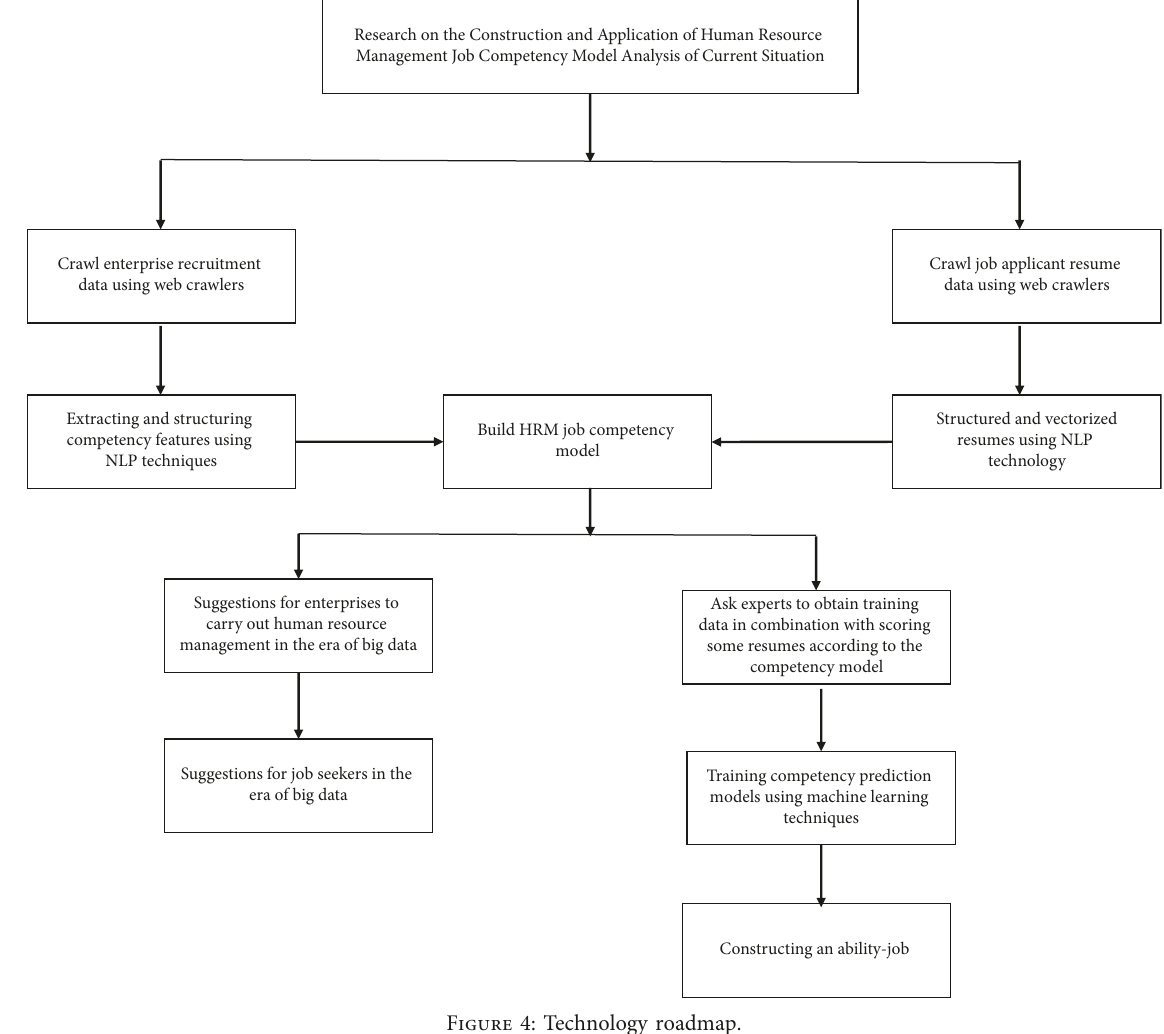
Figure 4: Technology roadmap.